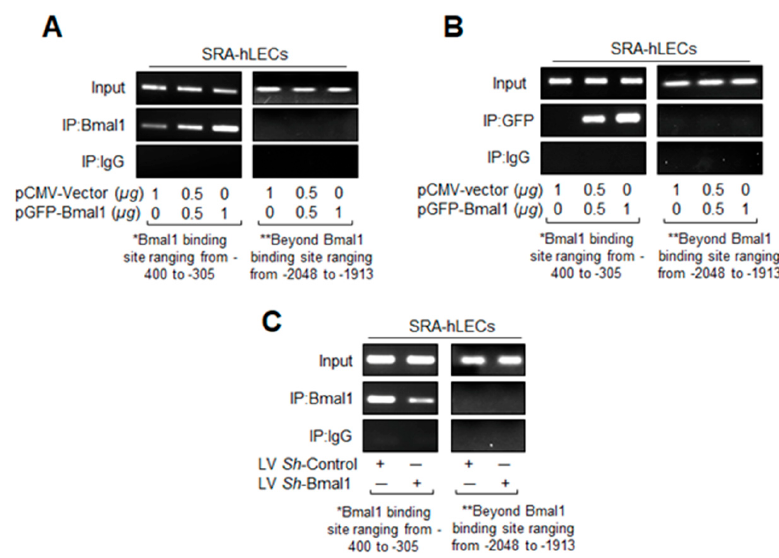
Figure 5. In vivo DNA binding assay revealed that cellular abundance of Bmal1 influenced its binding to E ‐ box sequences present in Prdx6 promoter. Diagrammatic sketch of the 5 ′‐ constructs of human Prdx6 gene promoter containing Bmal1 ‐ DNA binding sites and ChIP primers location and